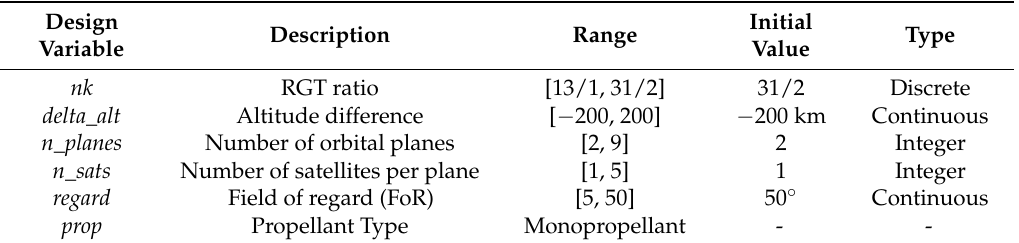
Table 10. Range and initial value of design variables in SA.